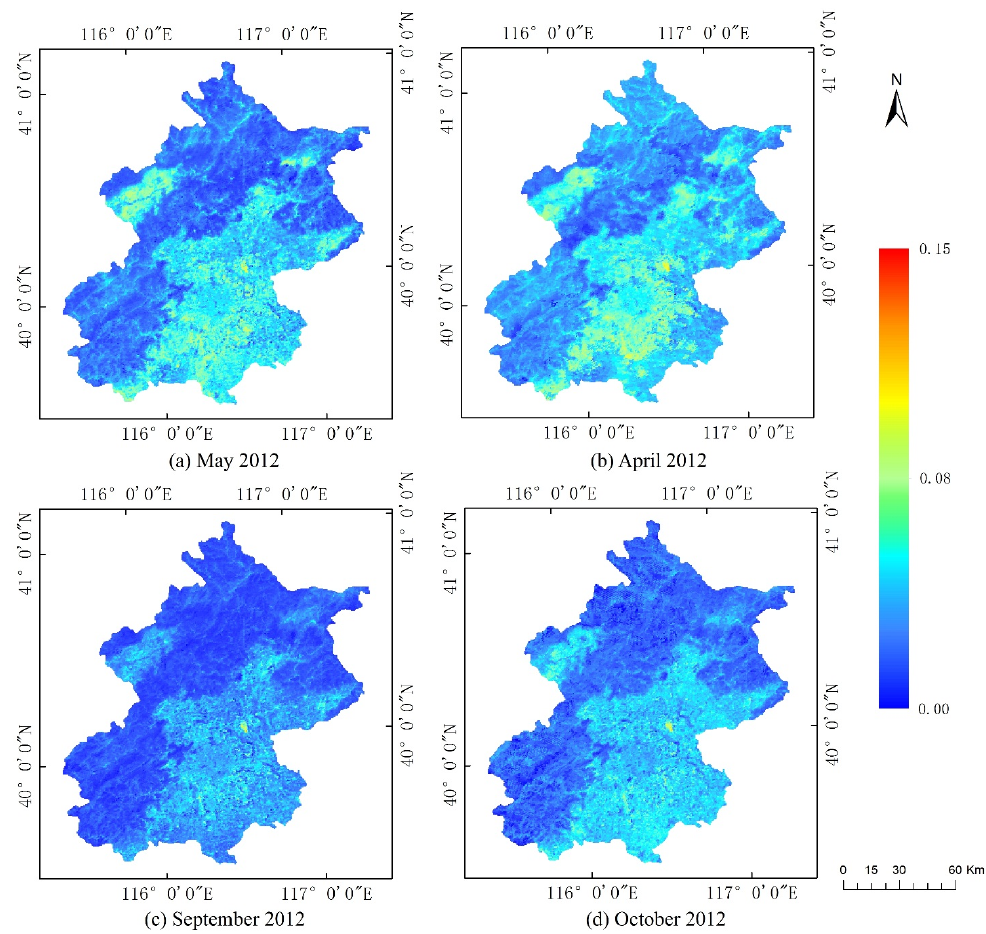
Figure 4. Corresponding MODerate-resolution Imaging Spectroradiometer (MODIS) surface reflectance images of in the blue band (0.47 μ m) in the Beijing area corresponding to the Landsat 8 OLI images in Figure 3. ( a ) May 2012; ( b ) April 2012; ( c ) September 2012; ( d ) October 2012.